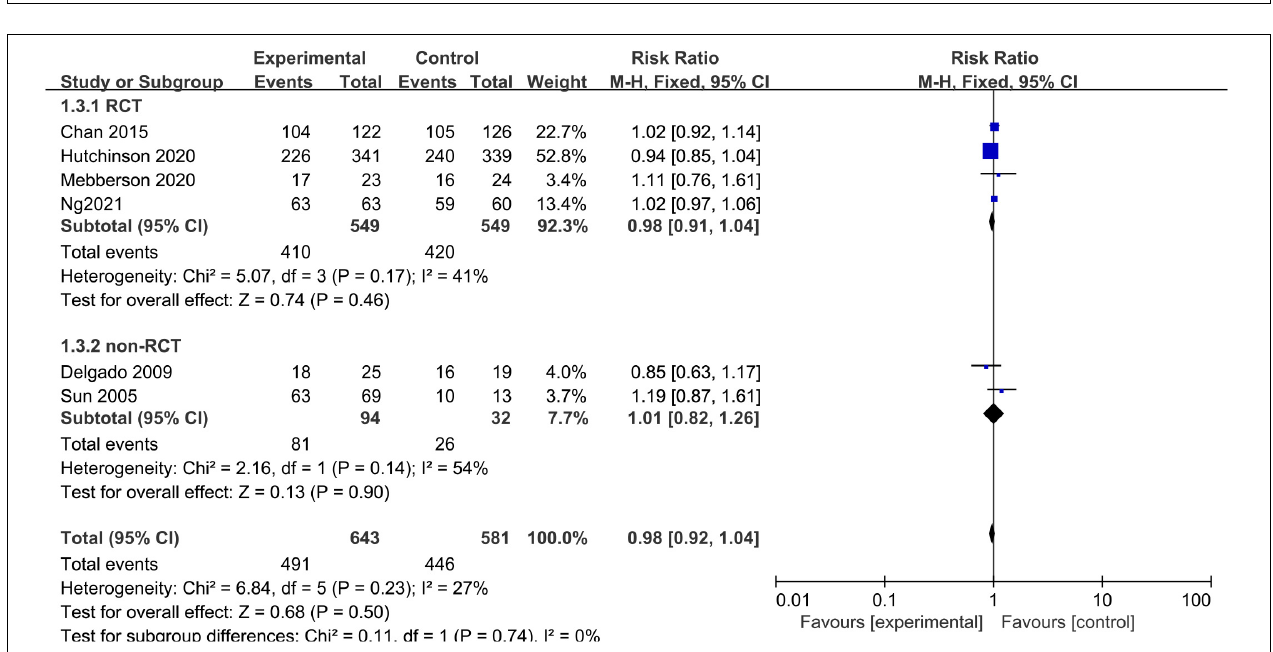
Frontiers in Neuroscience |